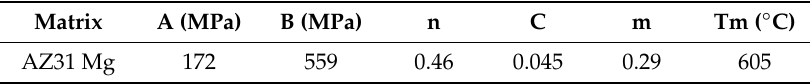
Table 4. Constants for AZ31 Magnesium used in this